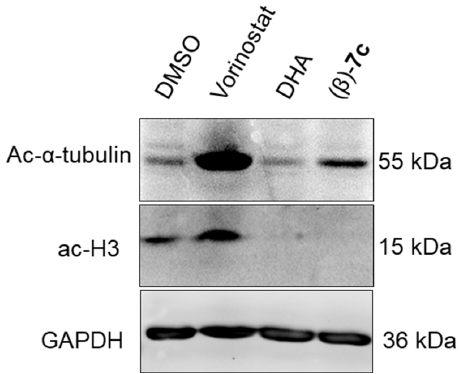
Figure 2. K562 cells were treated with DHA, ( β ) ‐ 7c , and vorinostat (0.4 μ M) for 24 h. Subsequently, cell lysates were immunobloted with anti ‐ acetyl ‐α‐ tubulin and acetyl ‐ histone H3 antibodies, whereas GAPDH served as a loading control. The experiments were repeated three times ( n = 3), and a representative blot is shown here.